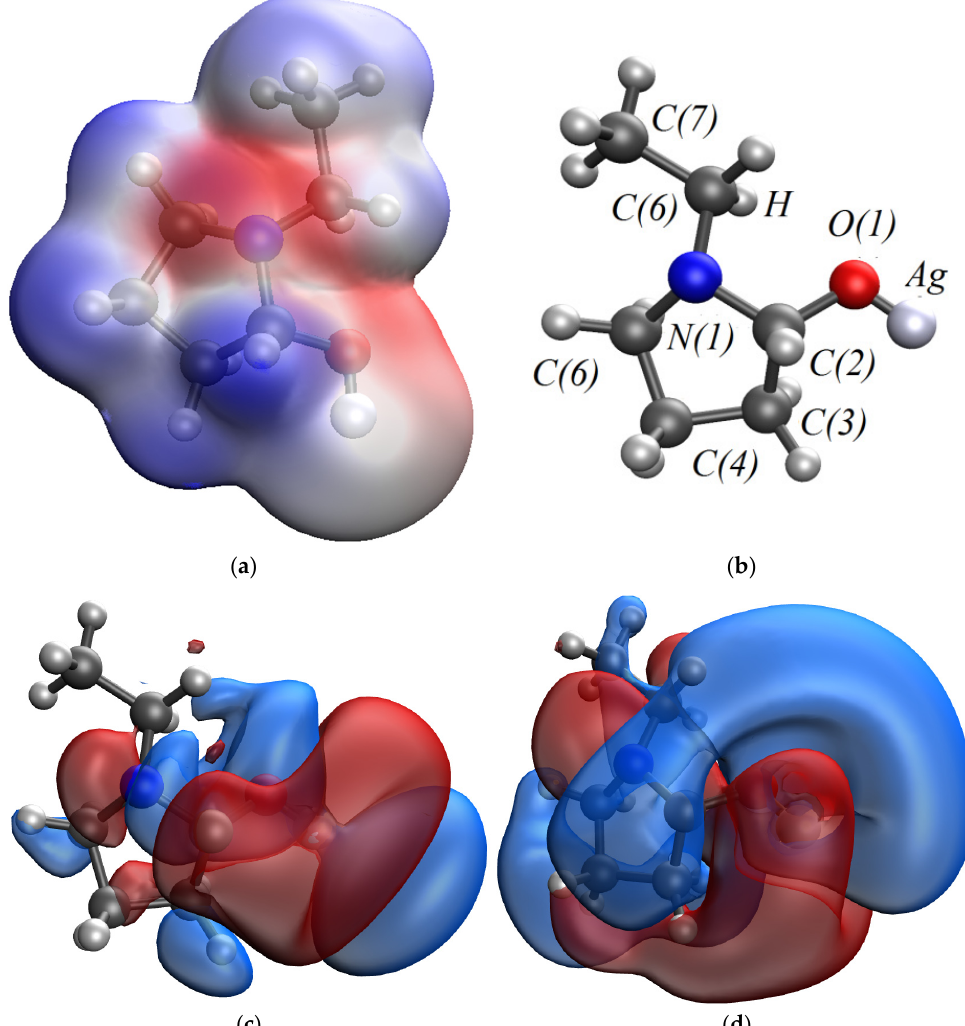
Figure 8. A model of the interaction of Ag atom with a PVP monomer unit through oxygen: ( a )—the electron density distribution, ( b )—the model of Ag-PVP molecular complex, ( c )—the model of the molecular orbital HOMO (highest occupied molecular orbital) and ( d )—the model of the molecular orbital LUMO (lowest unoccupied molecular orbital).